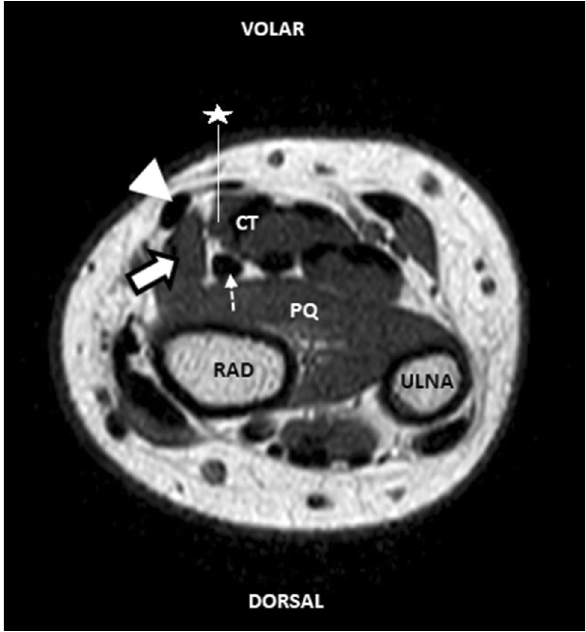
Figure 2. Axial T1W TSE MR image of the wrist; m. flexor carpi radialis tendon (arrowhead), m. flexor carpi radialis brevis (arrow), m. flexor pollicis longus (dotted arrow), carpal tunnel contents (CT), m. pronator quadratus (PQ), radius (RAD), n. medianus (star).